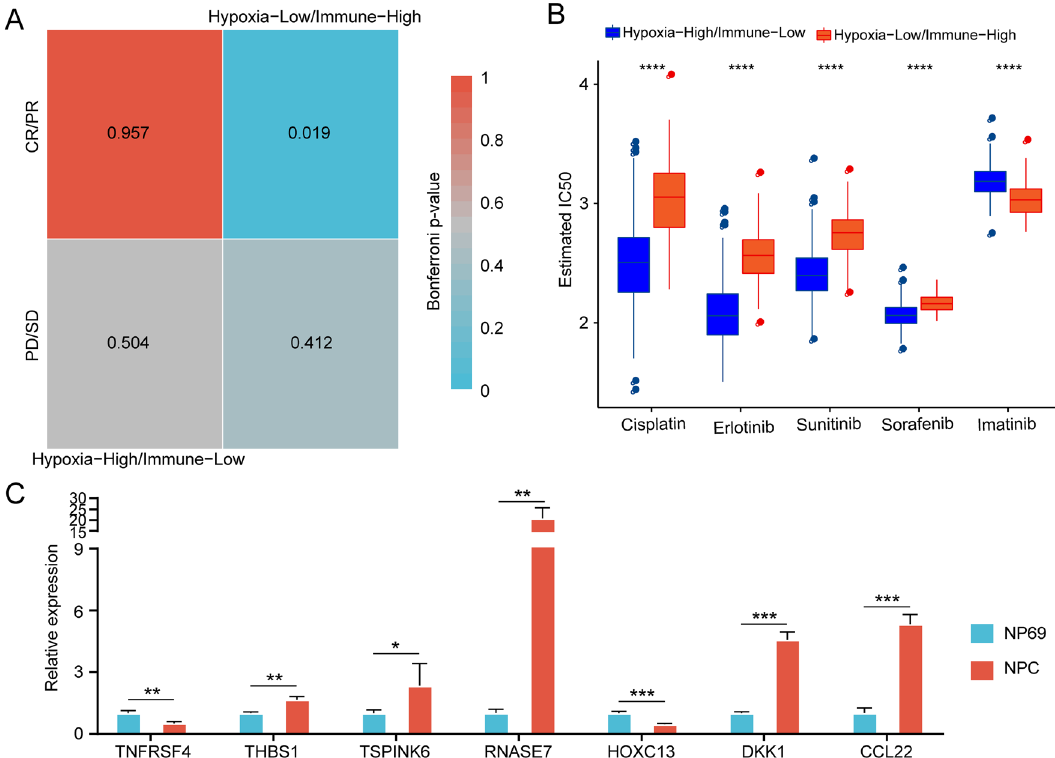
Figure 5. Differential analysis of immunotherapy and chemotherapy for hypoxic-immune subtypes. ( A ) Submap analysis showed that IC1 could be more sensitive to anti-PD-L1 treatment. ( B ) Box plots of the estimated IC50 values for cisplatin, erlotinib, sunitinib, sorafenib, and imatinib. ( C ) qRT-PCR analysis showed the expression levels of the key genes in NPC and NP69 cell lines. * p < 0.05, ** p < 0.01, *** p <